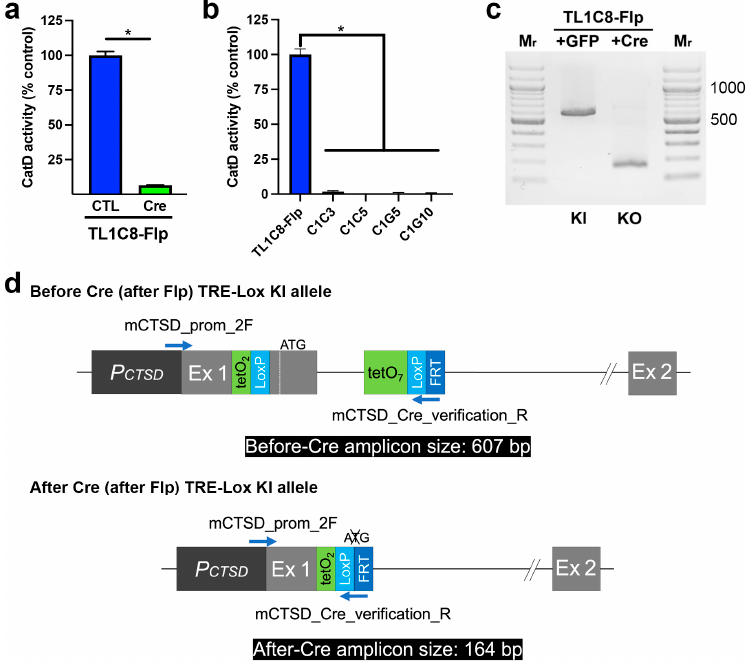
Figure 4. Functional and genotypic characterization of Cre-mediated genetic deletion of CatD made possible by the TRE-Lox system. ( a ) CatD activity in TL1C8-Flp cells transiently transfected with either GFP only (CTL, dark blue) or GFP-tagged Cre recombinase (Cre, green). Note that these are pools of GFP-positive cells selected by cell sorting 2 d after transfection. Data are mean ± SEM, n = 4, * p < 0.01. ( b ) CatD activity in multiple stable clones treated previously with Cre recombinase.